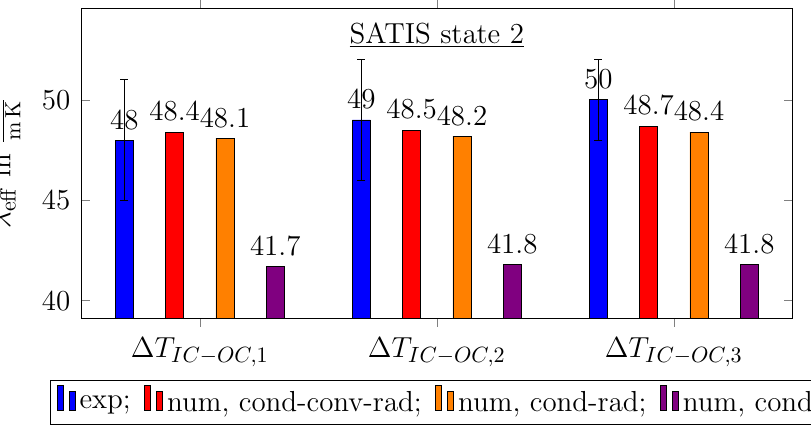
Figure 7. Experimentally (exp) and numerically (num) determined effective thermal conductivities ( λ eff ) of the SATIS panel in state 2 for the temperature differences listed in Table 1 taking into account the physical heat transport phenomena of heat conduction (cond), convection (conv) and thermal radiation